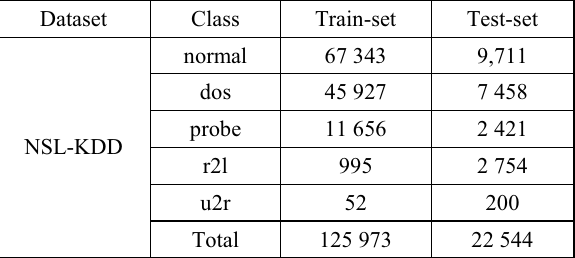
Table 2. NSL-KDD Datasets.